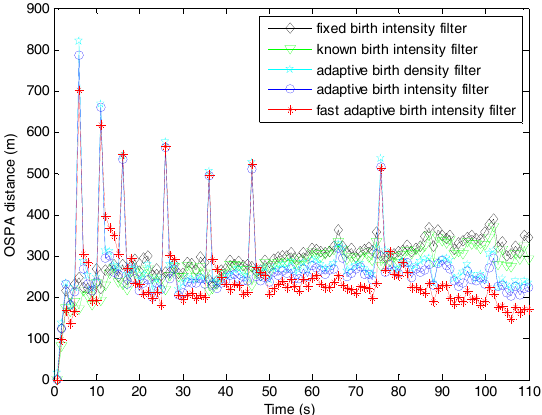
Figure 9. OSPA distances of the fast adaptive target birth intensity CBMeMBer filter and other CBMeMBer filters with different target birth models.